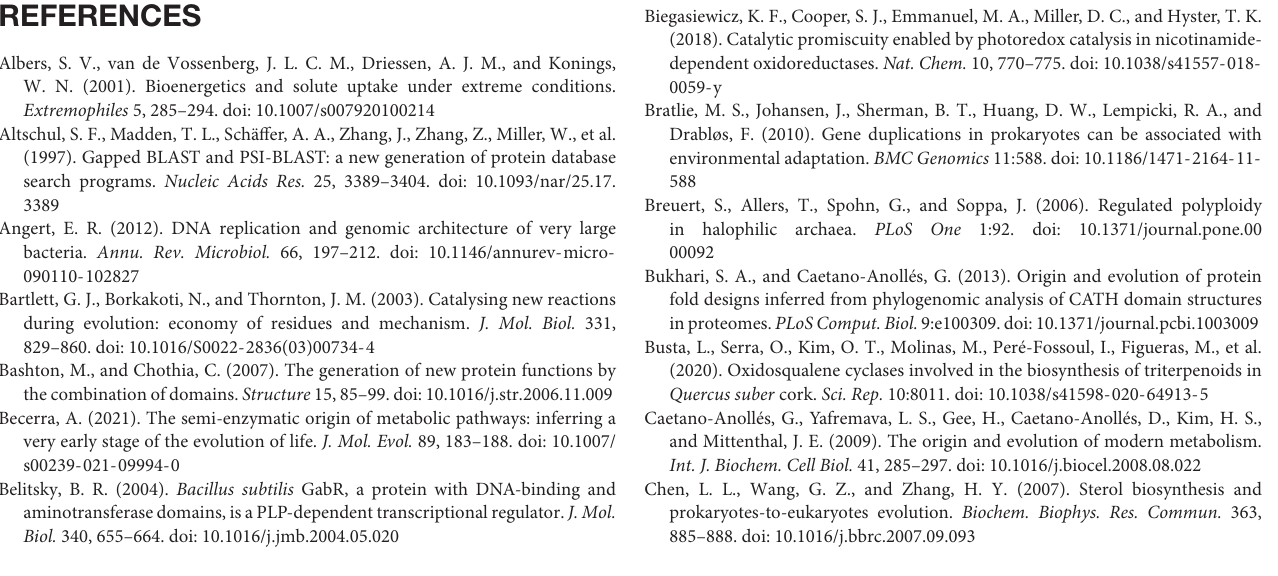
Supplementary Figure 1 | Relation between the enzyme and protein content, and the genome size in free-living organisms. For each pair of variables, a power-law equation is the one that best explains the distribution of the data. The equations and R -squared values are as follows: (A) y = 3.02 x 0 . 7 ; R 2 = 0.7; (B) y = 0.07 x 0 . 63 ; R 2 = 0.65; (C) y = 0.005 x 0 . 89 ; R 2 = 0.94. Supplementary Figure 2 | Relation between the enzyme and protein content, and the genome size in extremophile organisms. For each pair of variables, a linear regression equation is the one that best explains the distribution of the data. The equations and R -squared values are as follows: (A) y = 0.18 x + 247; R 2 = 0.72, (B) y = 1.46e − 04 x + 306; R 2 = 0.78; (C) y = 7.65e − 04 x + 457; R 2 = 0.96. Supplementary Figure 3 | Relation between the enzyme and protein content, and the genome size in pathogen organisms. For each pair of variables, a power-law equation is the one that best explains the distribution of the data. The equations and R -squared values are as follows: (A) y = 2.39 x 0 . 73 ; R 2 = 0.83; (B) y = 0.02 x 0 . 71 ; R 2 = 0.82; (C) y = 0.002 x 0 . 95 ; R 2 = 0.97. Supplementary Figure 4 | Relation between the enzyme and protein content, and the genome size in intracellular organisms. For panels (A,B) (number of enzymes vs. number of proteins, and number of enzymes vs. genome size), a linear equation is the one that best explains the distribution of the data. This is not the case for panel (C) , in which the data fits best to a power-law equation. The equations and R -squared values are as follows: (A) y = 0.25 x + 95; R 2 = 0.84; (B)